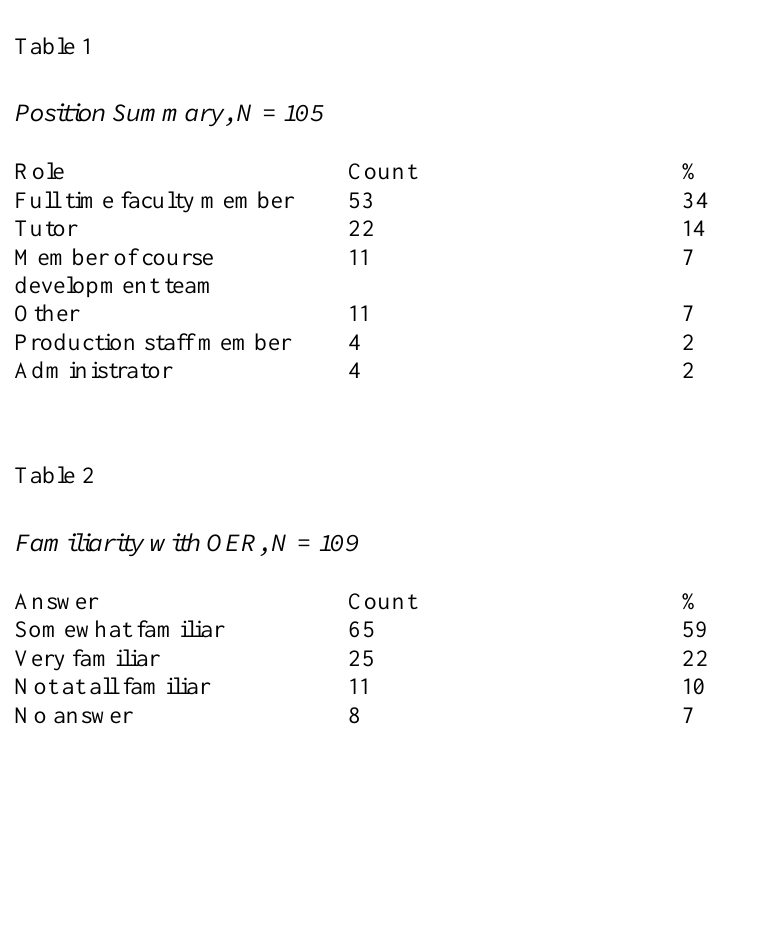
Familiarity with OER, N =